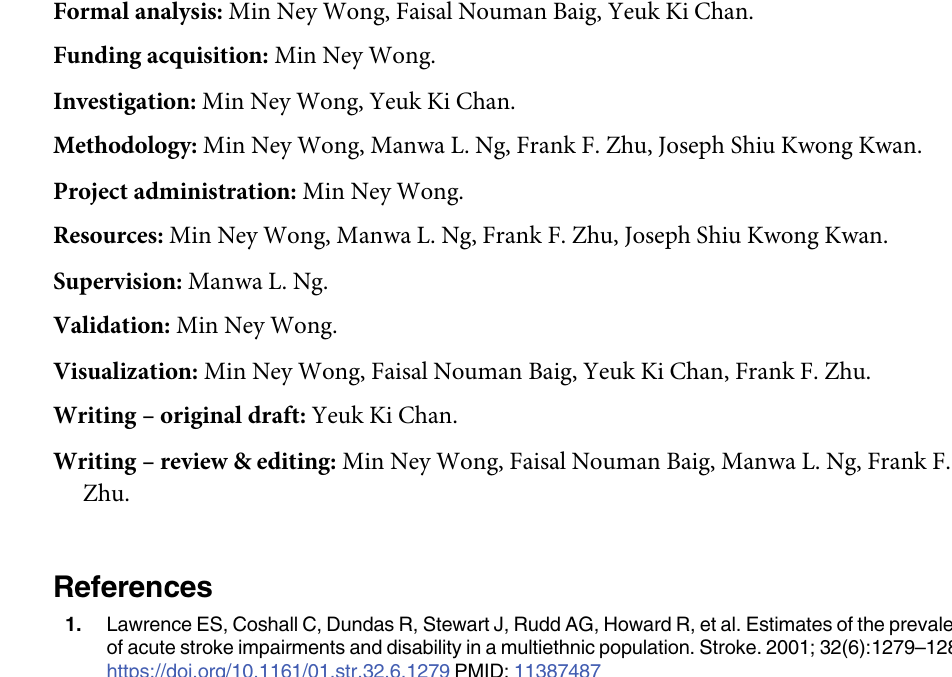
S3 Table. Raw data from perceptual analysis of passage reading. S4 Table. Raw data from perceptual analysis of diadochokinetic rate. S5 Table. Raw data from acoustic analysis. S6 Table. Raw data from kinematic